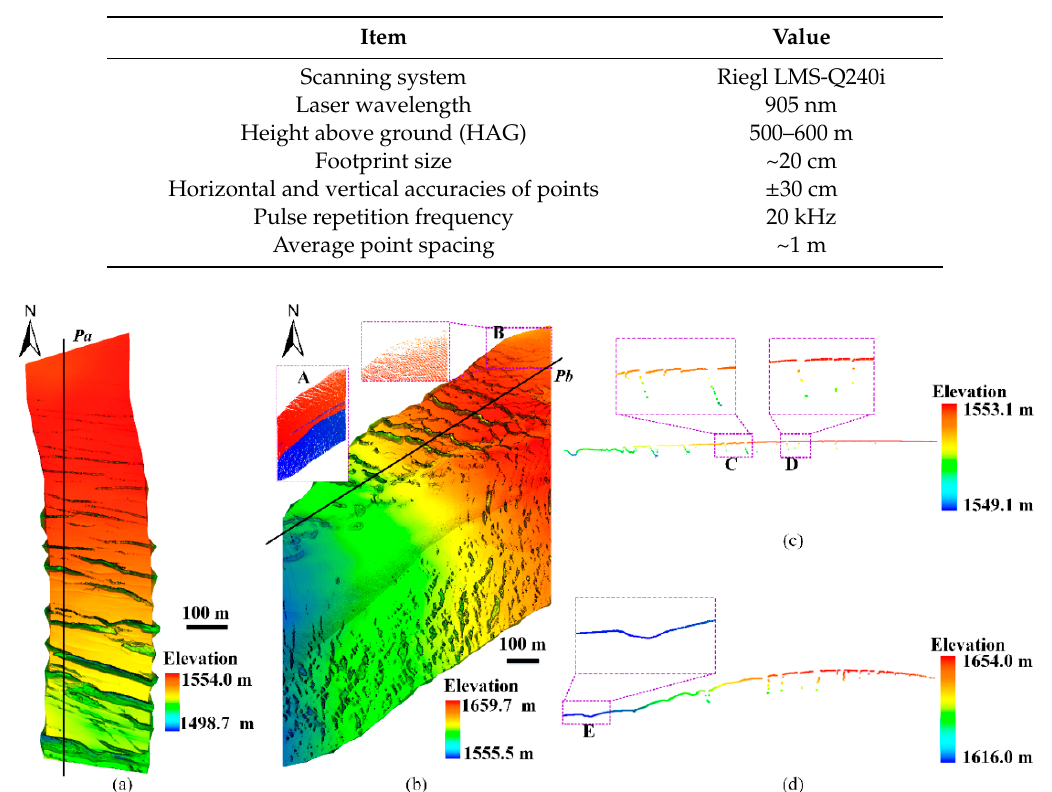
Table 1. General configuration of the University of Alaska Fairbanks (UAF) flight campaigns.